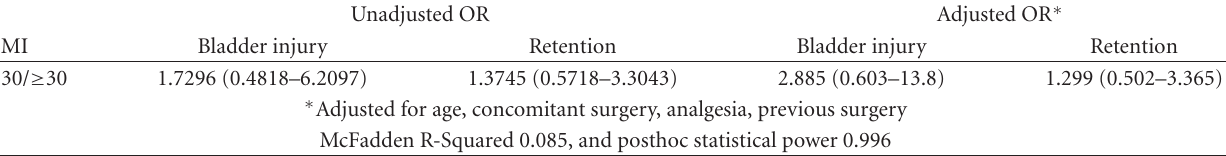
Table 2: Unadjusted and adjusted odds ratios (OR) (95% confidence interval) for specific complication by body mass index